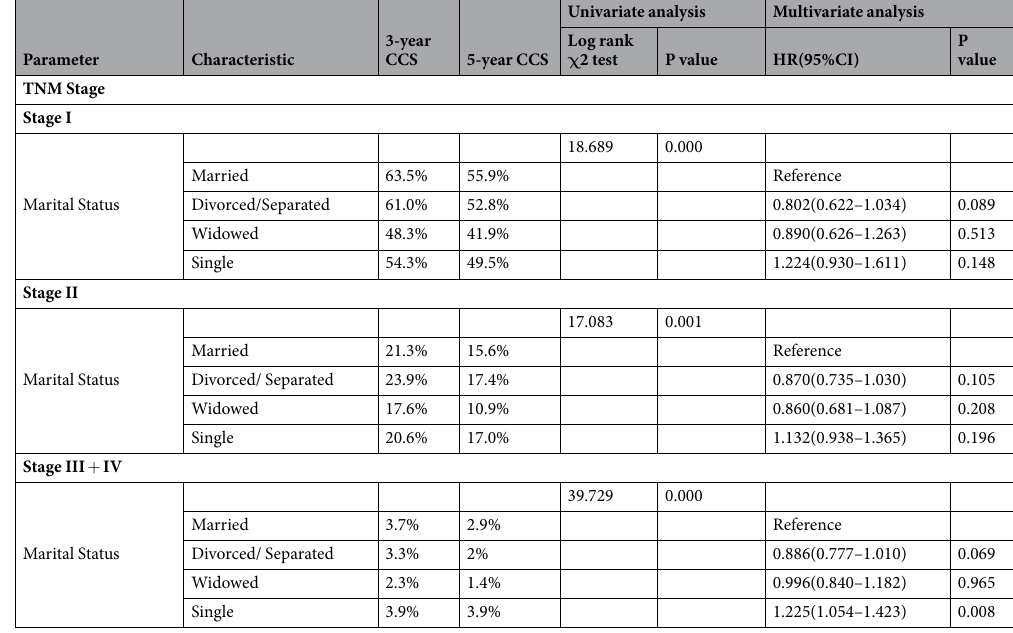
Table 3. Univariate and multivariate analysis of marital status on CSS of GBC patients based on TNM stage. P-values refer to comparisons between two groups and were adjusted for age, race, grade and histologic type as covariates. NI: not included in the multivariate survival